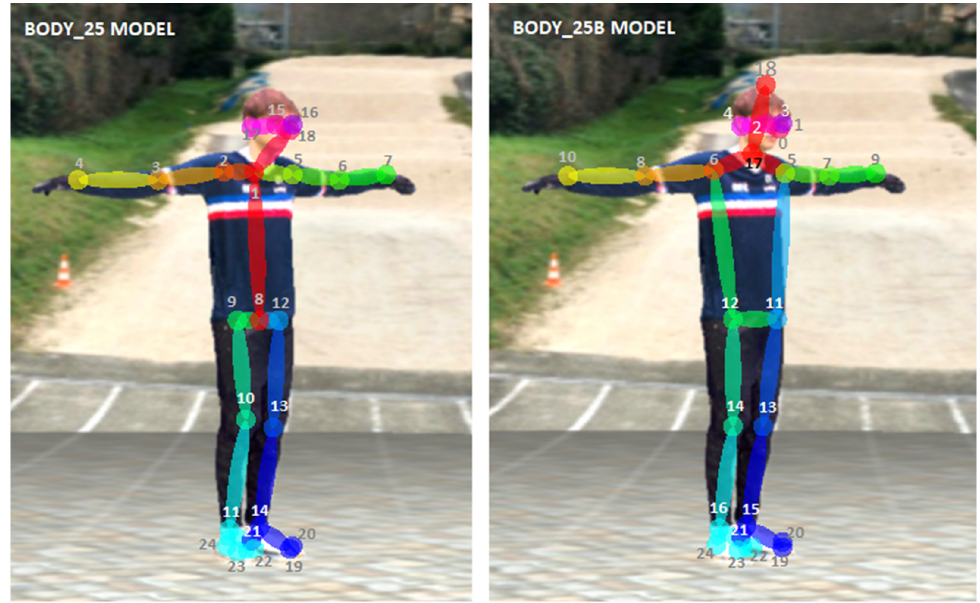
Figure 6. The experimental body_25b OpenPose model is more accurate than the default body_25 one. As an example, the left knee is slightly misplaced on the default model. The keypoint defini- tion differs between both